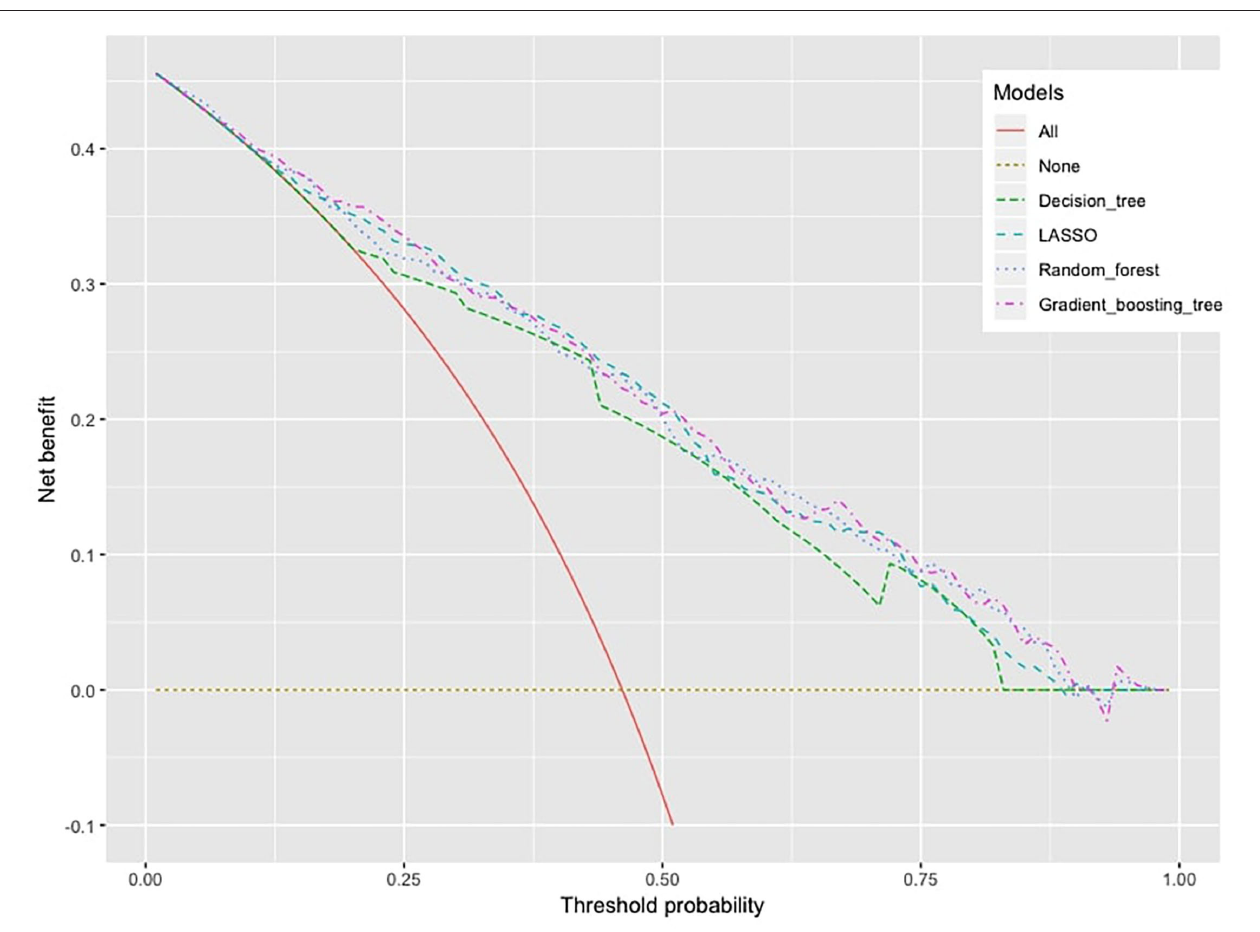
FIGURE 4 | Decision curve analysis, X -axis: threshold probability for machine learning models to make a prediction, Y -axis: net